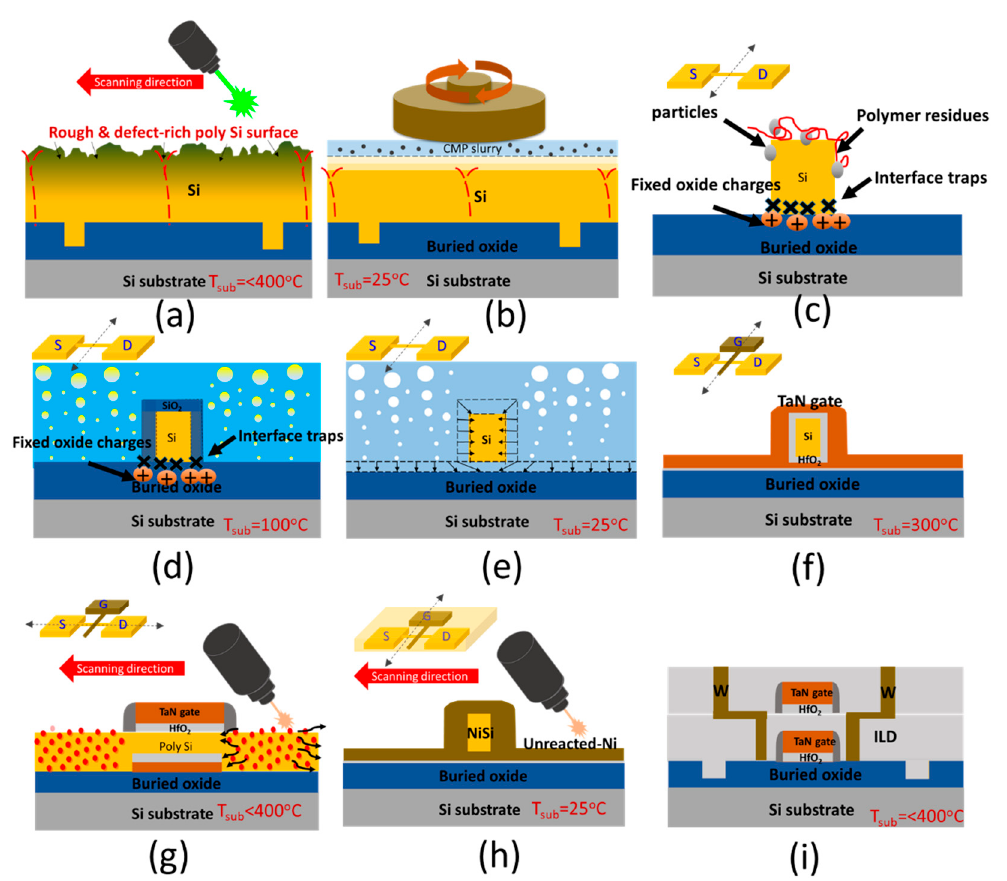
Figure 1. Schematics of process steps for 3D stackable single-grain gate-all-around (GAA) Si nanowire (NW) FET: ( a ) a-Si film was crystallized by GNS-LA; ( b ) the chemical mechanical polishing (CMP); ( c ) NW with defects was preliminary defined by lithography and ICP etching process in a Si gain; ( d ) soak into two mixture solutions to remove polymer residues and particles and immerse into pure H 2 O 2 to form sacrificial oxide on the Si NW surface; ( e ) suspend the Si NW by removing the sacrificial oxide using dilute HF solution; ( f ) high-K / metal gate (HK / MG) stack fabricated by ALD; ( g ) implantation and far-infrared laser annealing (FIR-LA) for dopant activation, ( h ) hybrid laser-assisted self-aligned silicide and ( i ) interlayer dielectric layer (ILD) deposition and following standard metallization using tungsten (W) interconnect.